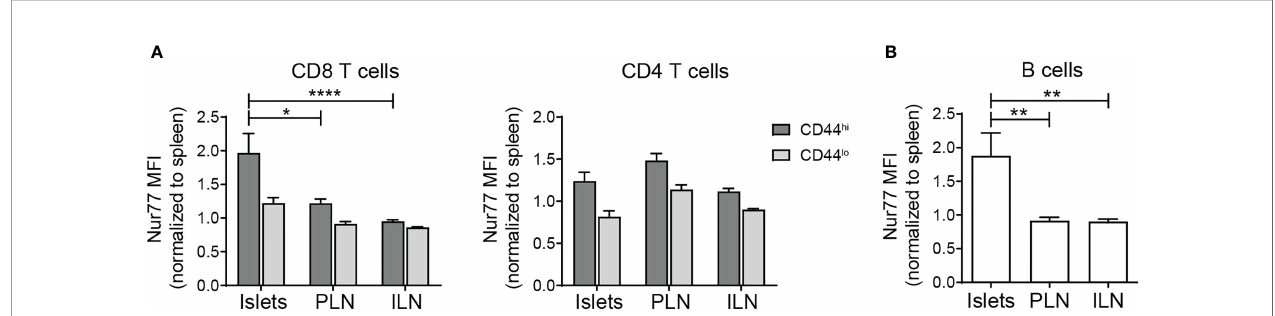
FIGURE 5 | Islet T cells and B cells receive local antigen stimulus. Flow cytometry analysis of C57/BL6.Nur77-GFP mice. Nur77-GFP mean fl uorescence intensity (MFI) was normalized to the same lymphocyte subset in the spleen to normalize between experiments. (A) Normalized Nur77-GFP expression in T cell subsets. (B) Normalized Nur77-GFP expression in B cells. (A, B) n=11 mice from 3 independent experiments. Statistics: *p < 0.05, **p < 0.01, ****p < 0.0001. Error bars: SEM. One way ANOVA with Sidak ’ s multiple comparisons